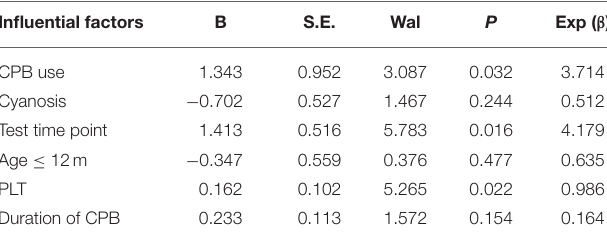
TABLE 3 | Logistic multivariate regressive analysis for decreased basal PAG-AA. Influential